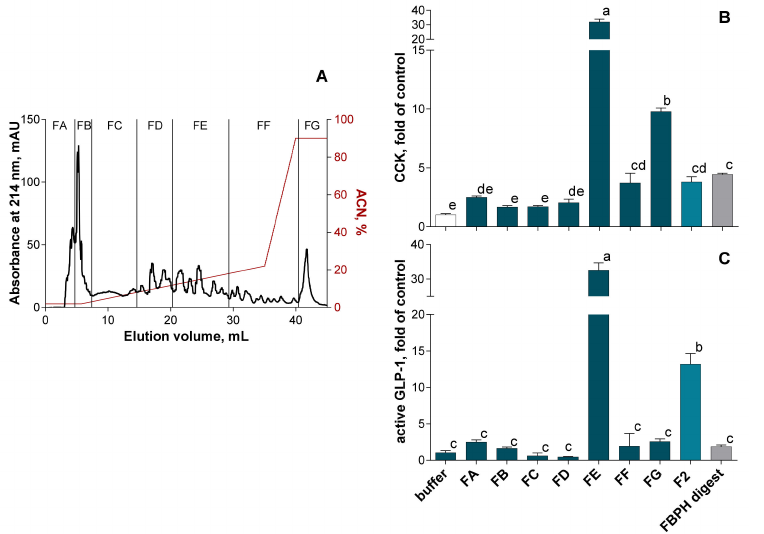
Figure 5. SEC-F2 RP-HPLC fractionation effect on gut hormones release in STC-1 cells. The RP- HPLC fractionation of the FBPH intestinal digest’s SEC-F2 fraction was performed using a C18 Gemini column (150 × 10 mm, particles of 5 µ m, 110 Å, Phenomenex) with an ACN gradient represented in red ( A ). The amounts of intestinal hormones released in the supernatants, after 2 h of contact, with the subfractions, the SEC-F2 fraction and the FBPH digest (0.5% w / v ), were determined by radioimmunoassay for CCK ( B ) and active GLP-1 ( C ). Values are means of three repeated measurements and are expressed in fold of control (buffer) ± SD. Means without a common letter within the same graph are significantly different ( p < 0.05) using one-way ANOVA following by Tukey post-hoc test for pairwise